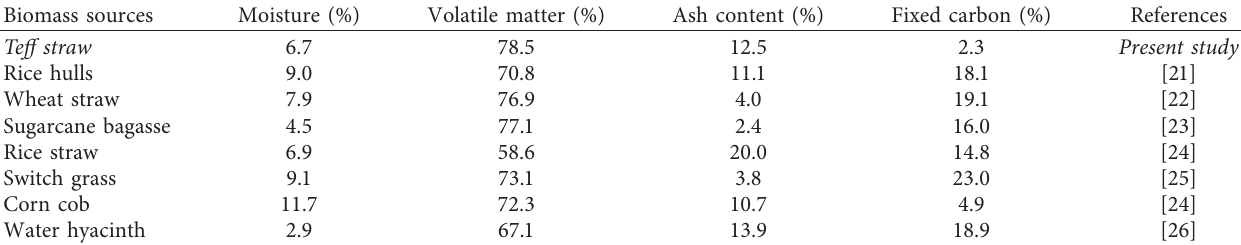
Table 3: Results of proximate analysis of Teff straw as compared to other biomass sources.